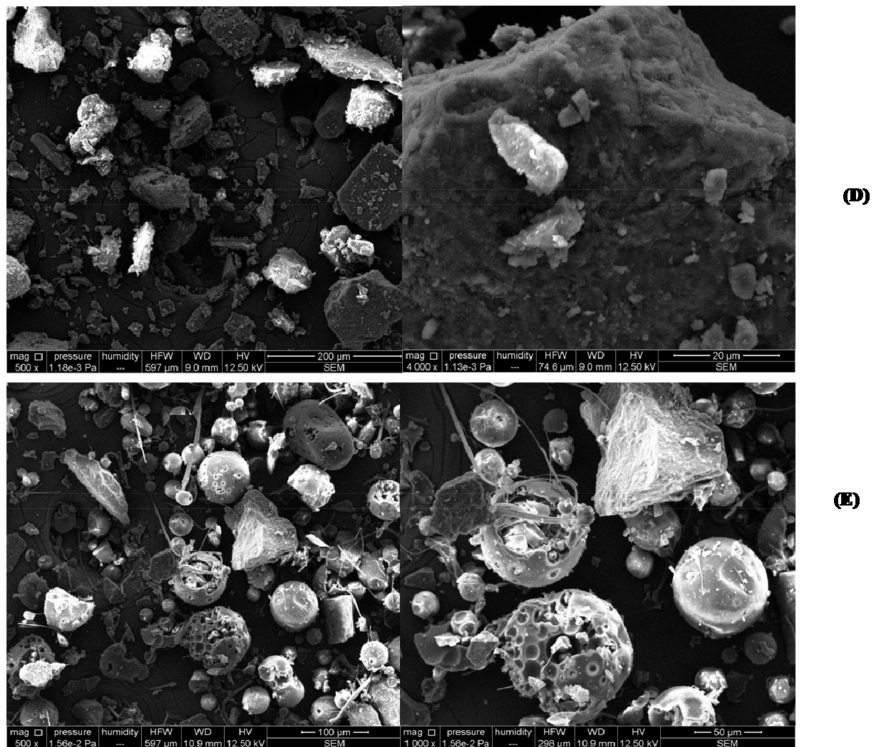
Figure 1. SEM images of ( A ) RUT, ( B ) β -CD, ( C ) HT- β -CD, ( D ) RUT- β -CD physical mixture, ( E ) RUT-HT- β -CD physical mixture, at different magnifications.